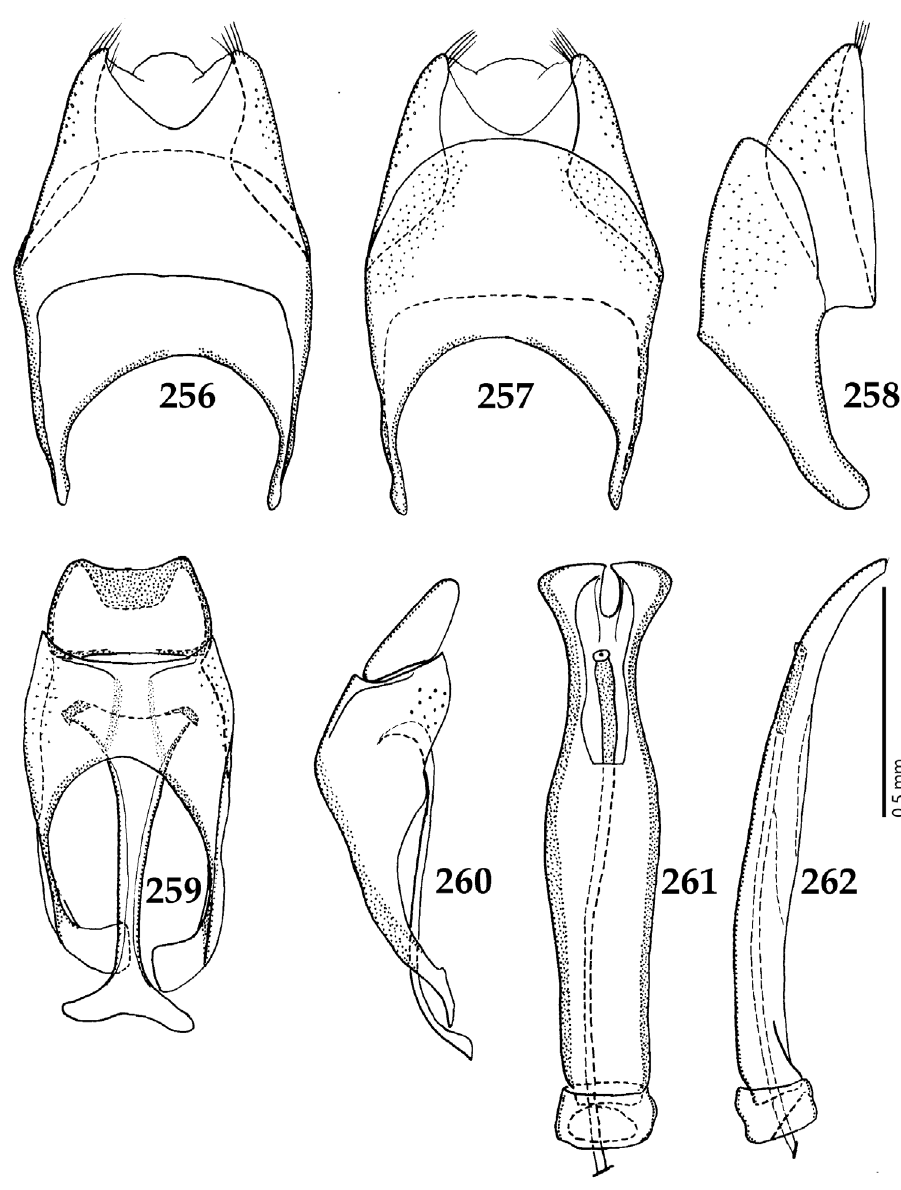
Figures 256–262. 256 Reichardtia pedator (Sharp, 1876) male terminalia: 8 th sternite + 8 th tergite, ventral view 257 ditto, dorsal view 258 ditto, lateral view 259 male terminalia: 9 th + 10 th tergites, dorsal view; spiculum gastrale, ventral view 260 male terminalia: 9 th + 10 th tergites; spiculum gastrale, lateral view 261 male terminalia: aedeagus, dorsal view 262 ditto, lateral